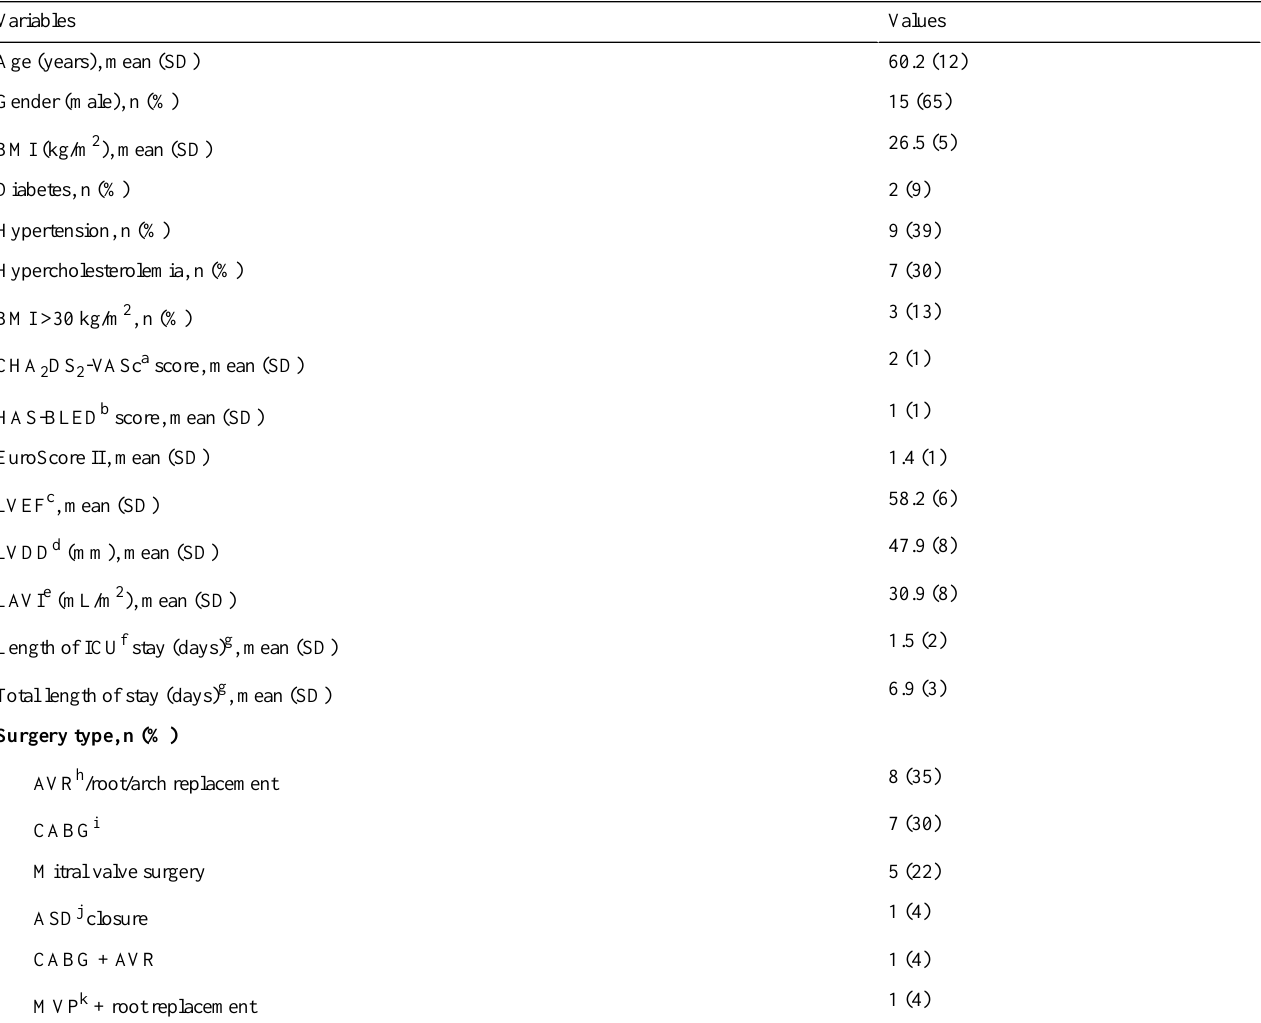
Table 1. Overview of (demographic) variables of the study population